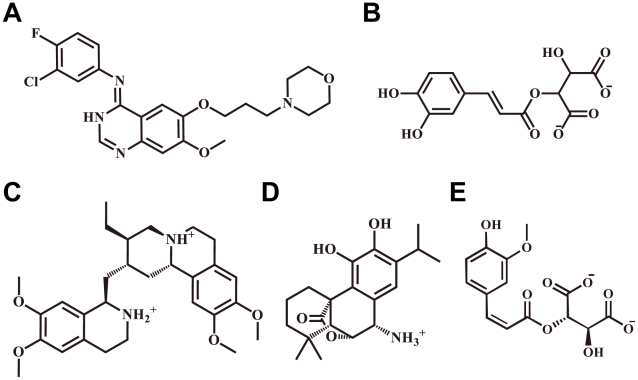
Scaffolds of the control and TCM compounds.(A) Iressa, (B) 2-O-Caffeoyl tartaric acid, (C) Emetine, (D) Rosmaricine, and (E) 2-O-Feruloyl tartaric acid.